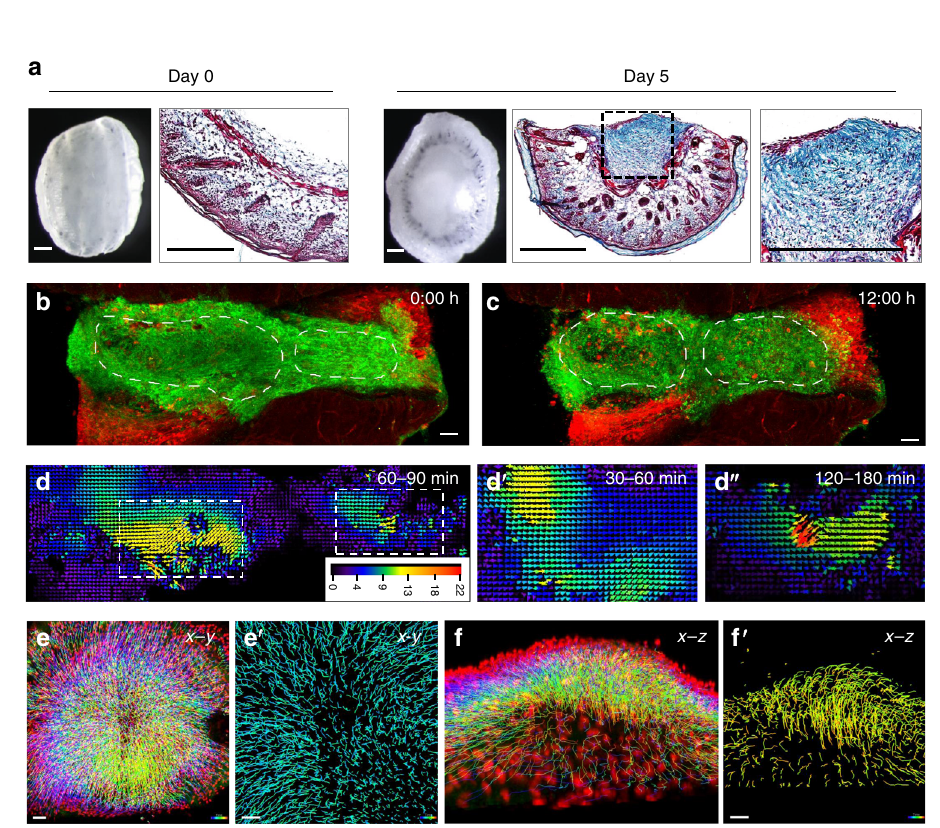
Fig. 2 Fascia EPFs swarm during scarring in SCAD. a Whole-mount bright- fi eld images and Masson ’ s trichrome staining with collagen in blue of fresh SCAD (day 0) and after 5-day culture (day 5). n > 1000. b , c Snapshots of live imaging of day 3 En1 Cre ;R26 mTmG SCAD. Two independent EPF aggregates are encircled with a dotted line at time t = 0 h ( b ) and t = 12 h ( c ) (Supplementary Movie 4). Images are representative of four biological replicates. d PIV analysis of GFP channel from live imaging showed in Supplementary Movie 4. Arrowheads indicate the direction of particle movement. Particle velocity is indicated by a scale from slow (blue) to fast (red). Scale bar unit: pixel. d ′ – d ″ Vector map from PIV analysis of the left swarm over 30 – 60 min ( d ′ ) and of the right swarm over 120 – 180 mins ( d ″ ). e , f Colour-coded tracking of EPFs from live imaging (72 – 96 h) of En1 Cre ;R26 LSL-H2B-mCherry SCAD, from top view ( e ) and side view ( f ). Colours indicate time, starting from blue to red at the end of the movie (Supplementary Movie 6). e ′ Enlarged images of EPF migration tracks in the scar centre at the beginning of swarming (blue-to-cyan). f ′ Enlarged images of EPF migration tracks at the end of swarming (green- to-orange). Images are representative of four biological replicates. Scale bars: a = 500 µ m; b , c , e , f = 50 µ m; e ′ , f ′ = 30 µ